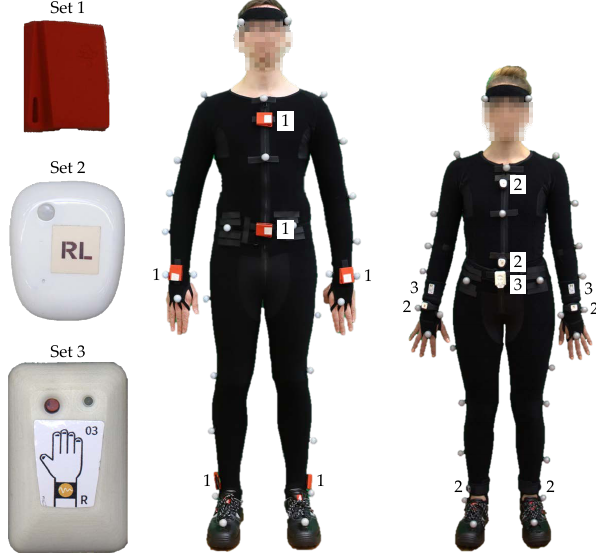
Figure 9. Positions of on-body devices (inertial measurement unit (IMU)) from set 1 (Texas Instruments Incorporated), set 2 (MbientLab), and set 3 (MotionMiners